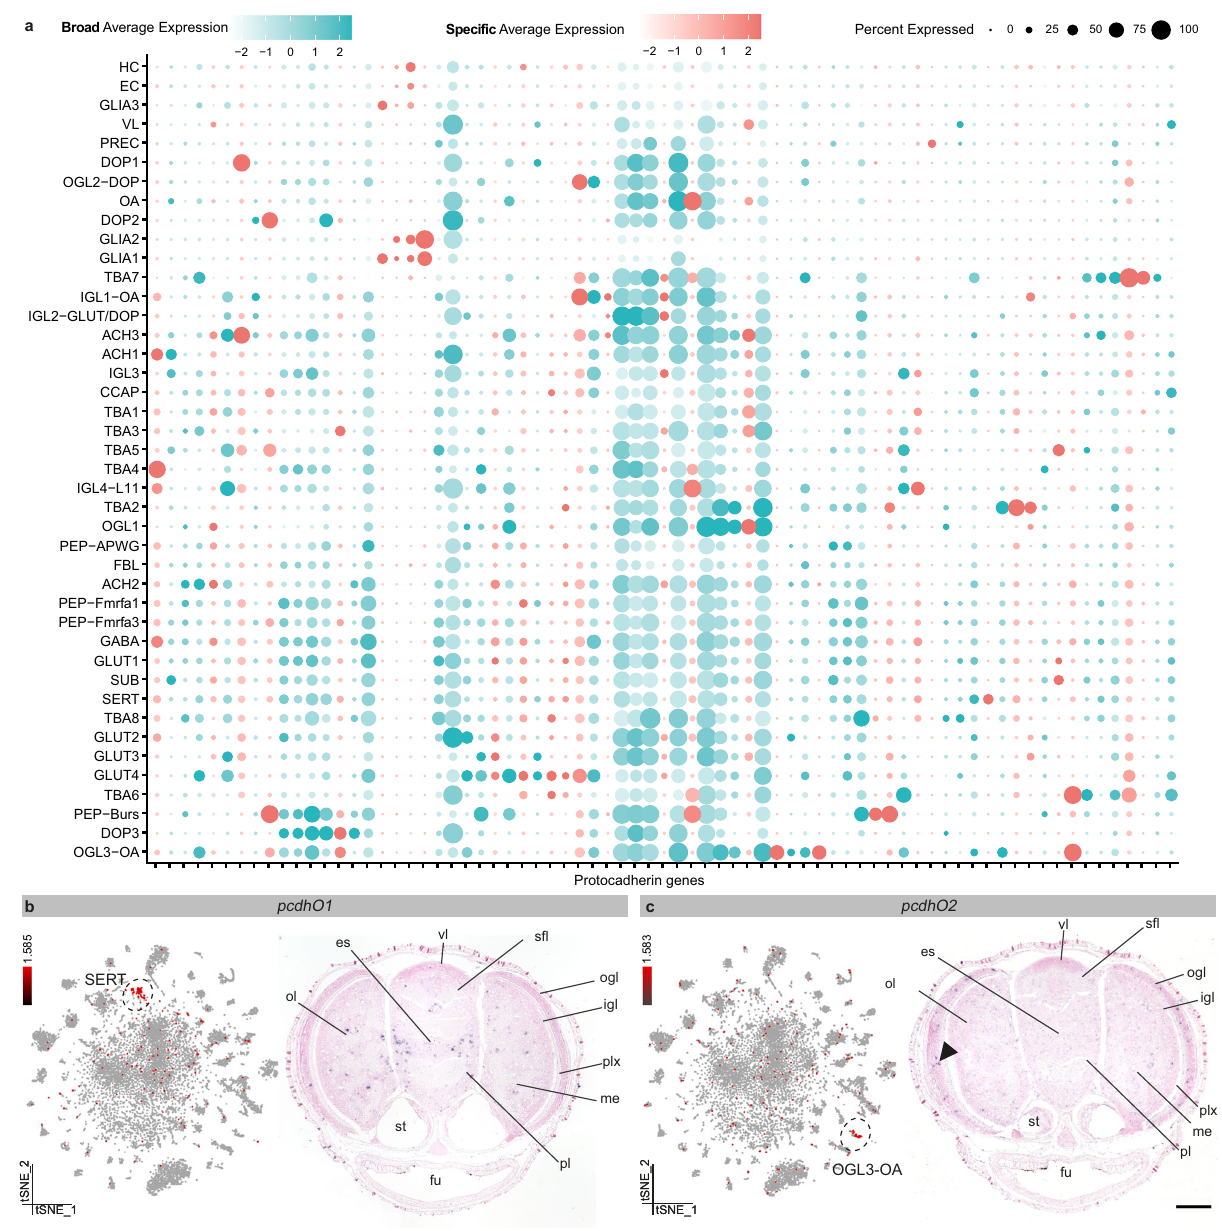
c Protocadherin O2 ( pcdhO2 ) is expressed within the octopaminergic neurons localized intheoutergranularlayer(OGL3-OA),apositive signalisindicatedwitha blackarrow.Scalebarsrepresent100 µ m.esesophagus,fufunnel,iglinnergranular layer, me medulla, ogl outer granular layer, ol optic lobe, pl pedal lobe, plx plexi- form layer, s fl superior frontal lobe, st statocysts, vl vertical